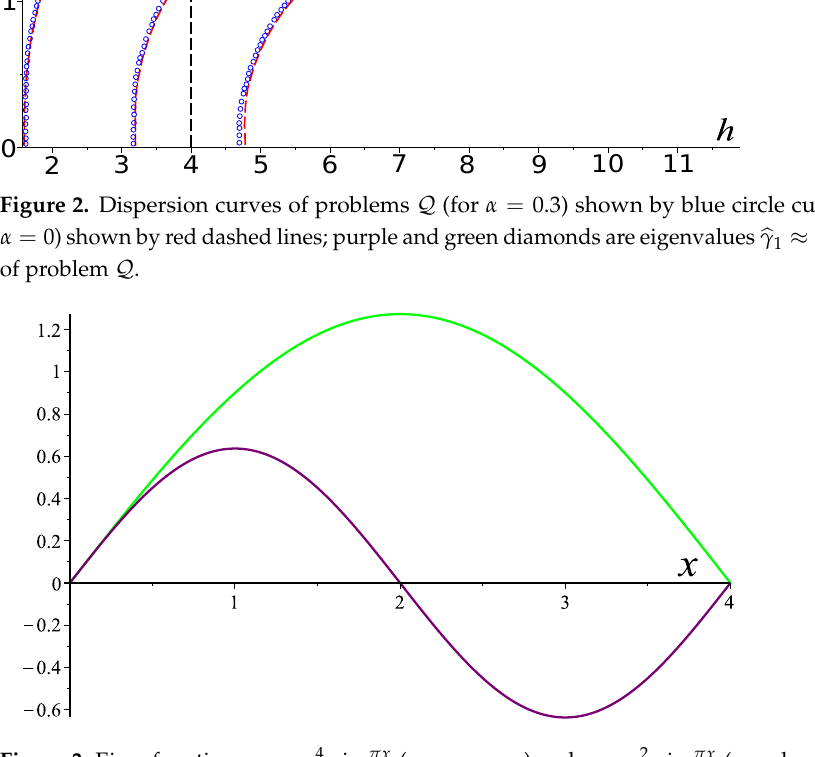
sin π x (green curve) and u 2 = 2 π 4 γ 1 and γ 2 , respectively. (cid:98) (cid:98)